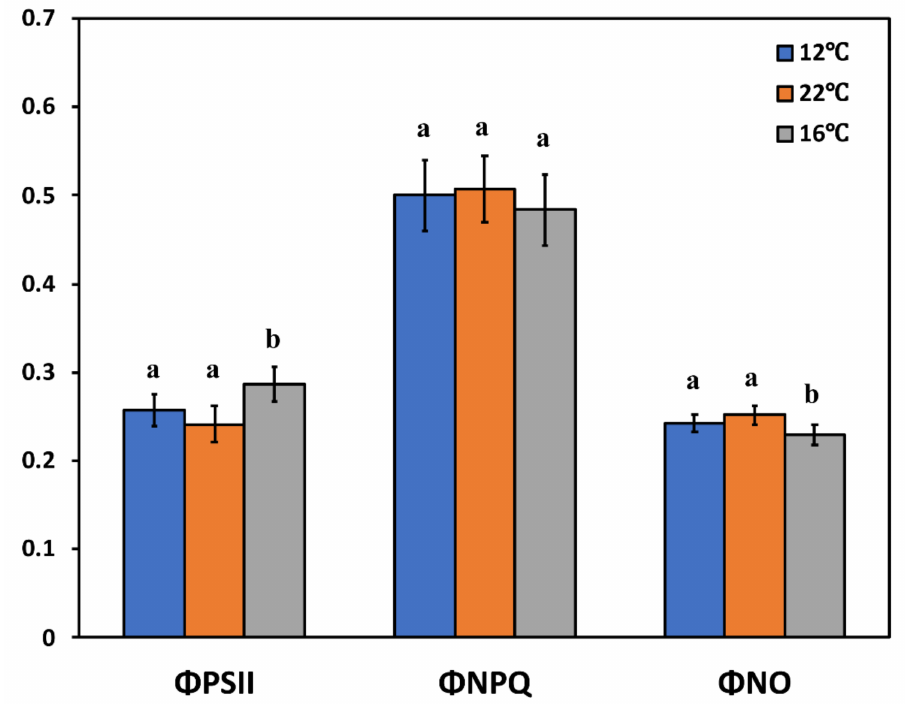
Figure 3. The quantum yields of photosystem II (PSII) photochemistry ( Φ PSII), of regulated non- photochemical energy loss ( Φ NPQ), and of non-regulated energy loss ( Φ NO) of rocket plants grown in non-heated tanks (12 ◦ C), in grid-heated tanks (22 ◦ C), and in solar-panel-powered tanks (16 ◦ C). Error bars on columns are standard deviations based on six leaves from different plants. Different letters represent a significantly different mean for the same parameter ( p <